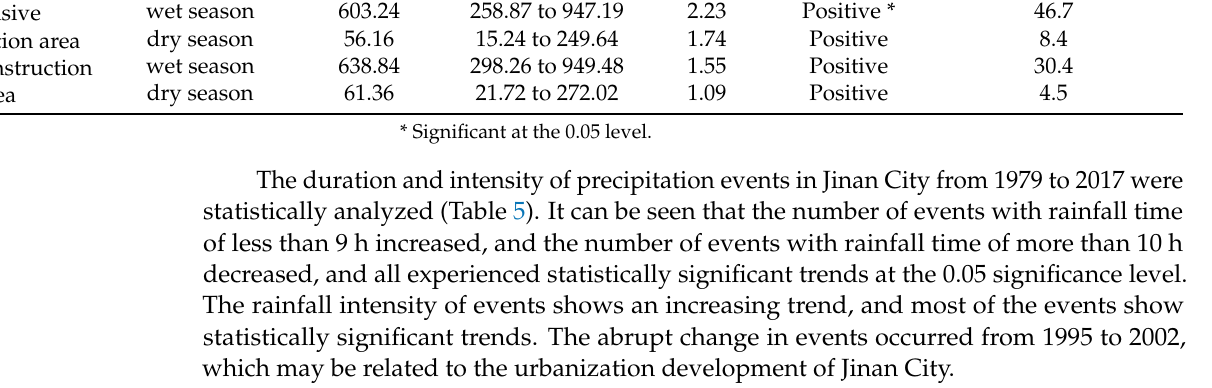
Figure 6. The trend of precipitation in Jinan City during the period of 1979–2017. Table 4. Characteristic of precipitation in wet season and dry season in Jinan City during the period of 1979–2017.